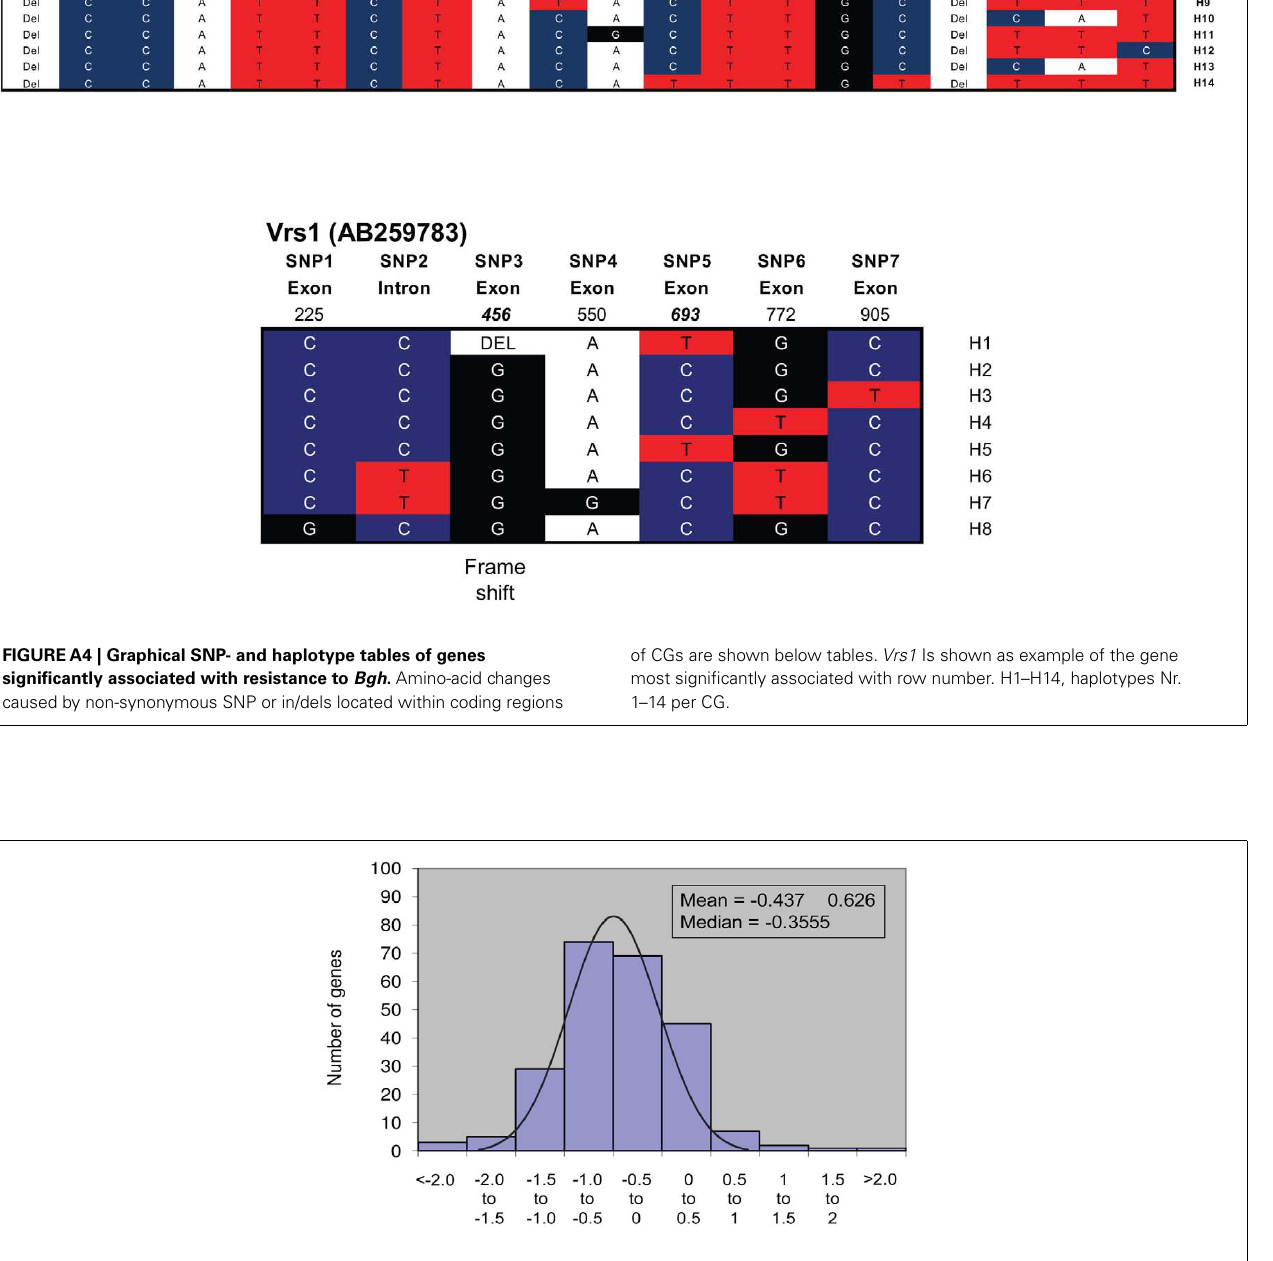
first-roundTIGS screenings. The median value of this distribution was used for the null hypothesis in one-sample t -tests for significance ofTIGS